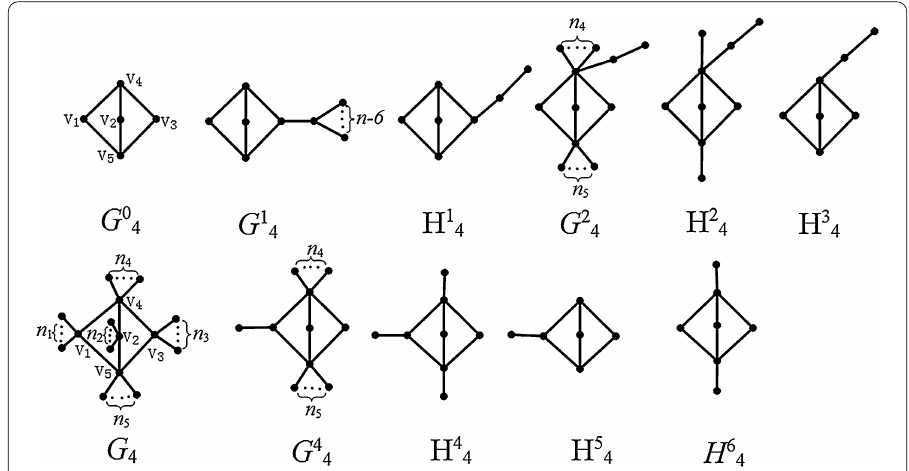
Figure 6 Some bicyclic graphs with θ (3,3,3) as their